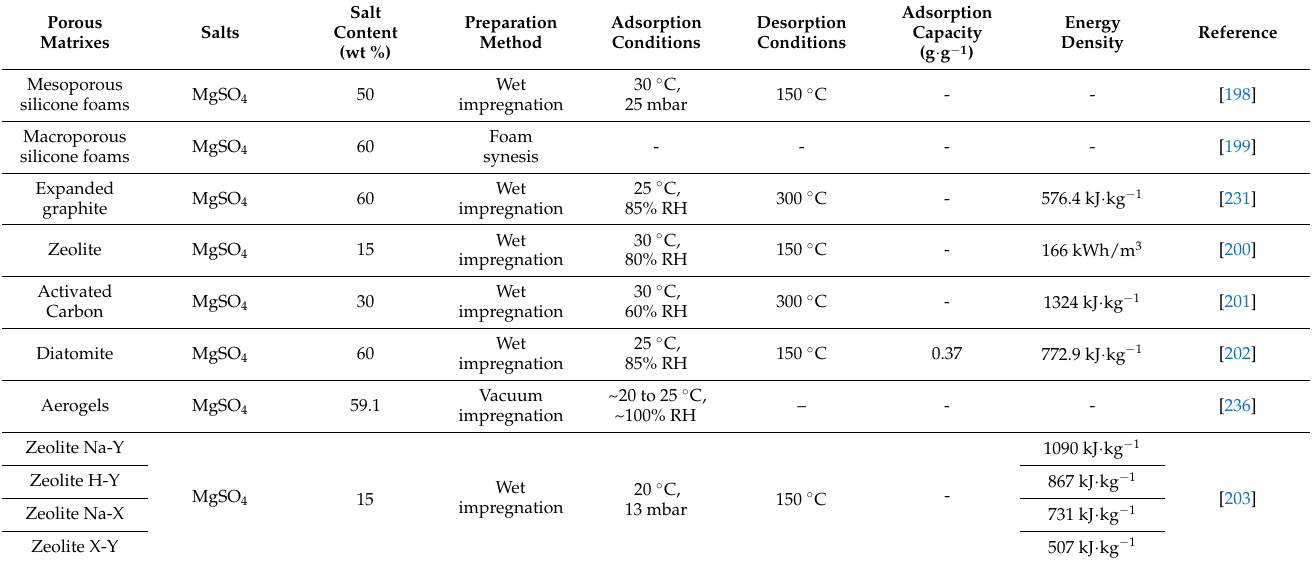
Table 7. Advancements of salt hydrate composite materials for thermochemical energy